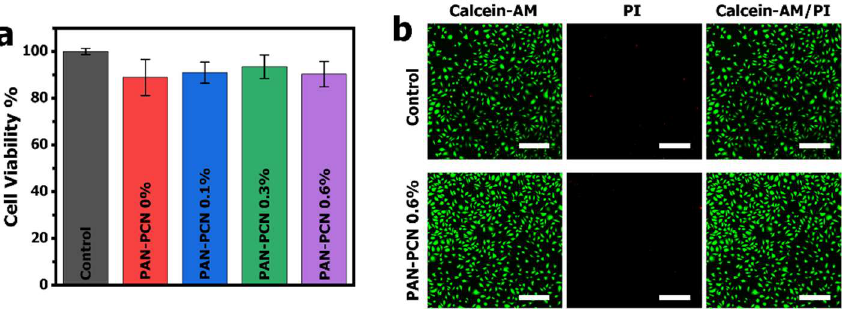
Figure 8. ( a ) Viability (%) of L929 cells treated by PAN-PCN 0%, PAN-PCN 0.1%, PAN-PCN 0.3% and PAN-PCN 0.6% after co-incubation for 24 h. ( b ) Fluorescence microscopy images of L929 cells treated by PAN-PCN 0.6% after 24 h co-incubation. The scale bars inserted in panel ( b ) are 300 μm.